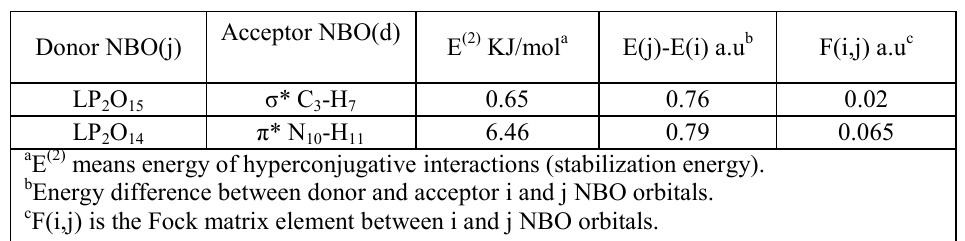
Table 4 . Second–order perturbation theory analysis of Fock-matrix in NBO analysis corresponding to the intermolecular C-H--O hydrogen bonds of ANP.